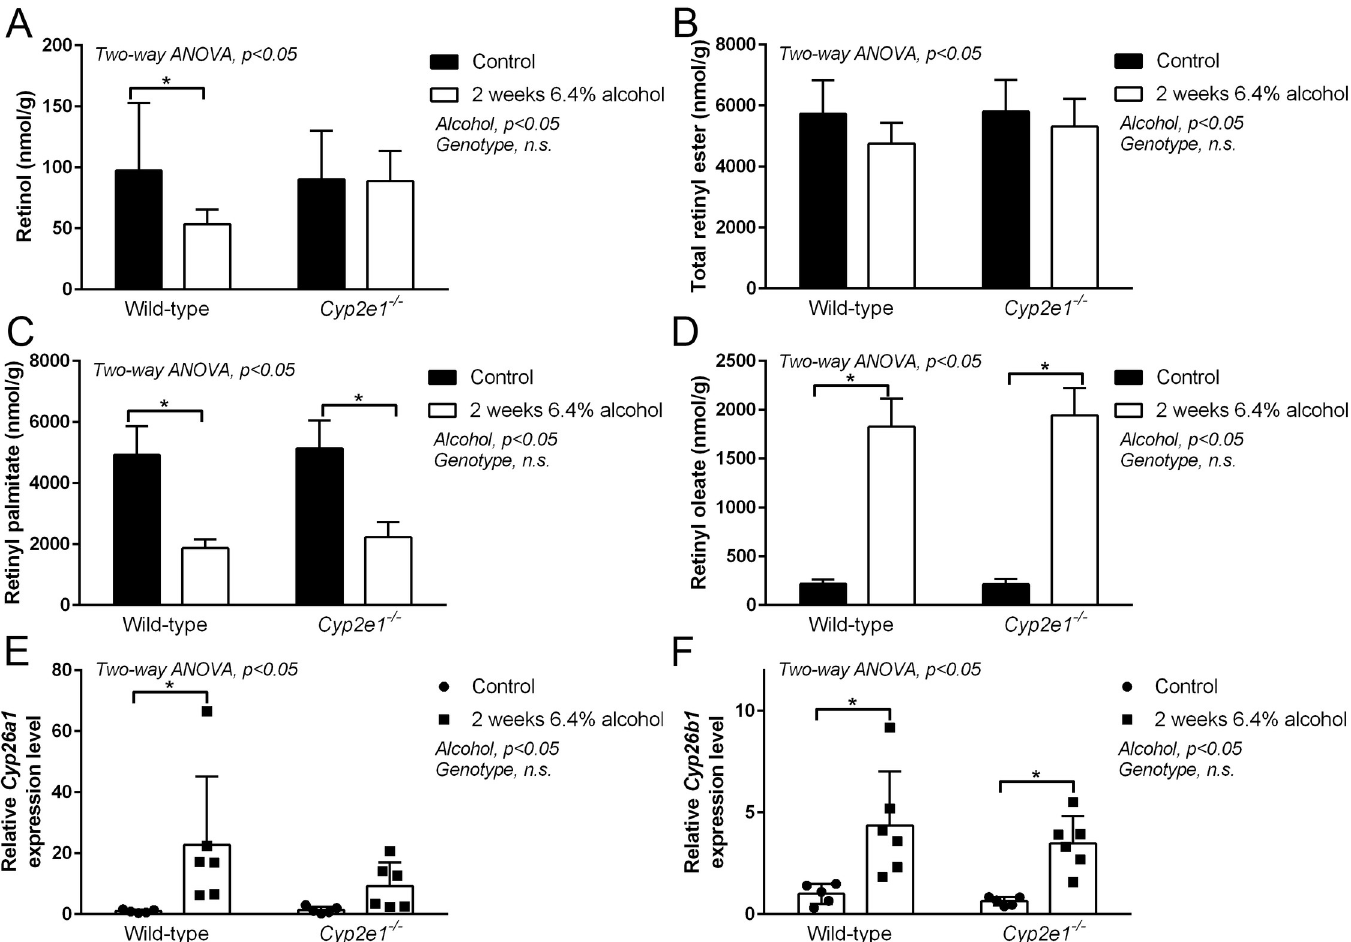
Fig 3. Effect of genetic ablation of CYP2E1 on alcohol induced hepatic retinoid metabolism. Consumption of 6.4% alcohol for 2 weeks significantly decreased hepatic retinol level in wild type (WT) mice but did not affect retinol levels in Cyp2e1 -/- mice (A). Total hepatic retinyl ester levels are not significantly different between WT and Cyp2e1 -/- mice (B). Consumption of 6.4% alcohol for 2 weeks significantly decreased hepatic retinyl palmitate levels in both WT mice and Cyp2e1 -/- mice (C). Consumption of 6.4% alcohol for 2 weeks significantly increased hepatic retinyl oleate level in both WT mice and Cyp2e1 -/- mice (D). Consumption of 6.4% alcohol for 2 weeks significantly increased Cyp26a1 expression levels in the WT mice not in the Cyp2e1 -/- mice (E). Consumption of 6.4% alcohol for 2 weeks significantly increased Cyp26b1 expression level both in the WT and Cyp2e1 -/- mice (F). Data analyzed by Two-way ANOVA; � P < 0.05 vs . control for Tukey’s multiple comparison post-test (A-F).